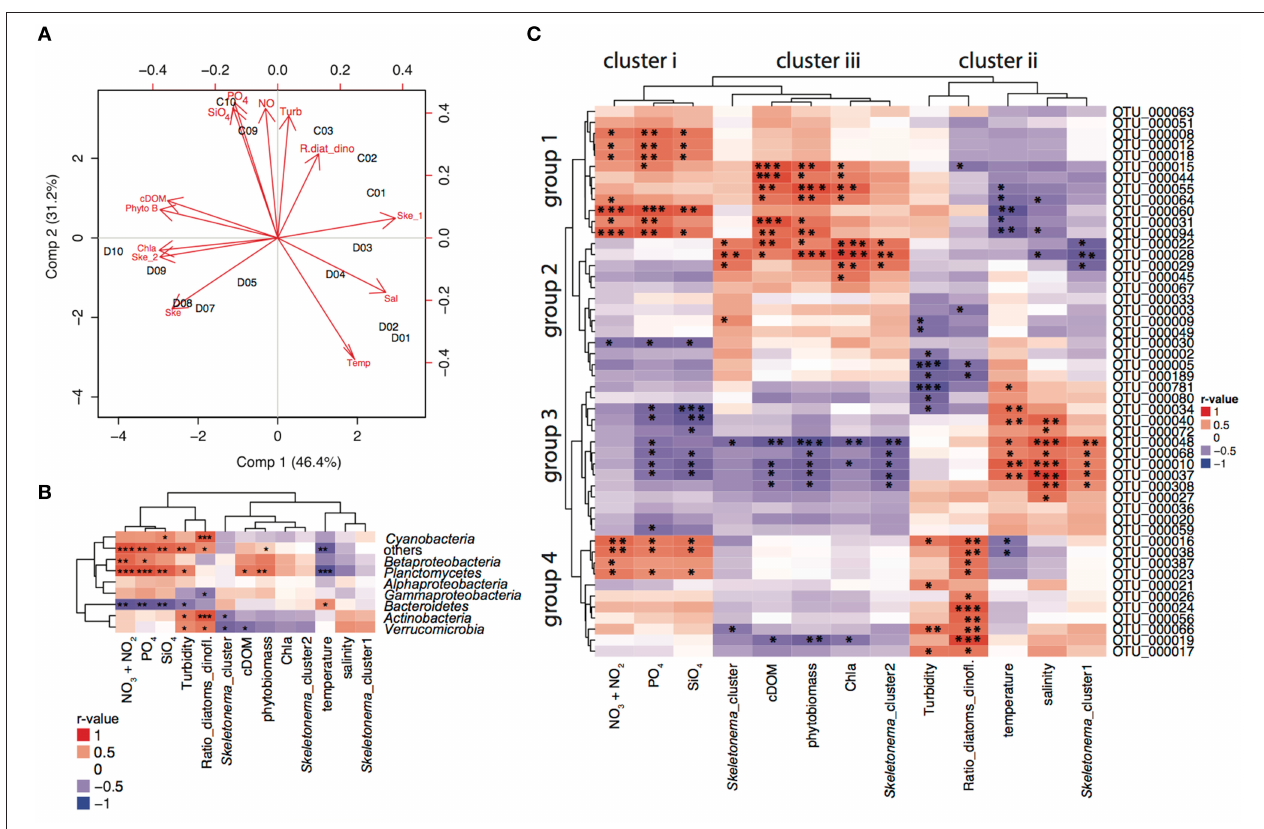
FIGURE 3 | PLSr and correlations to environmental variables. (A) Partial least squares regression analysis (PLSr) linking bacterial community composition (including all OTUs) with environmental variables and biotic factors in stations 1–3, 9–10 during cruise C, and 1–10 during cruise D. Red short labels describe the environmental variables (PO 4 ; phosphate, NO; nitrate and nitrite, SiO 4 ; silicate, Turb; turbidity, R.diat_dino; diatom/dinoflagelate ratio, cDOM; colored fluorescent DOM, Phyto B; phytoplankton biomass, Chla; chlorophyll a fluorescence, Ske_2; S. marinoi cluster 2, Ske; S. marinoi cluster, Temp; temperature, Sal; salinity, Ske_1; S. marinoi cluster 1) whereas black labels describe the sampling stations. (B) Correlation analysis between relative abundances of bacterial families and environmental variables based on Pearson correlations for relative abundances of bacterial families and environmental variables. Correlation values depict r -values of Pearson correlations and the dendograms are based on Pearson correlations. Statistical significance levels: * p < 0.05, ** p < 0.01, *** p < 0.001. (C) Correlation analysis between relative abundances of 50 most abundant OTUs and environmental variables based on Pearson correlations. Correlation values depict r -values of